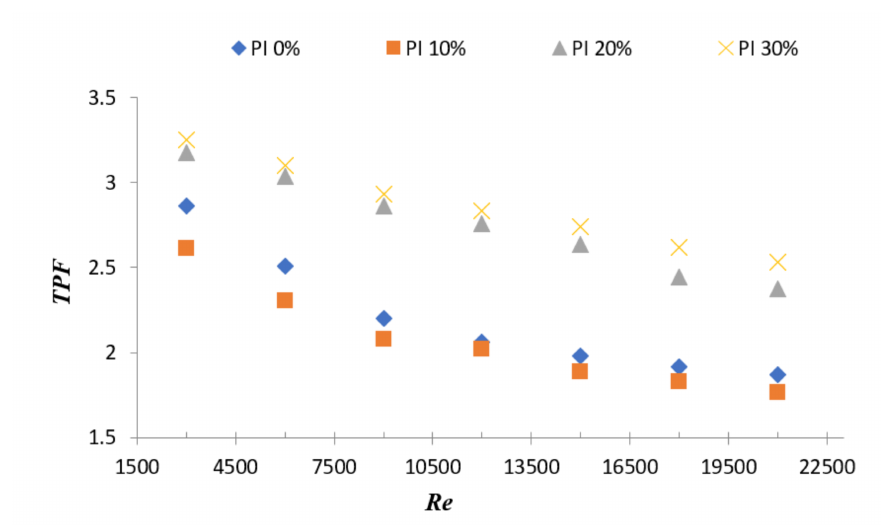
Figure 8. Variation of f/fs with Re .